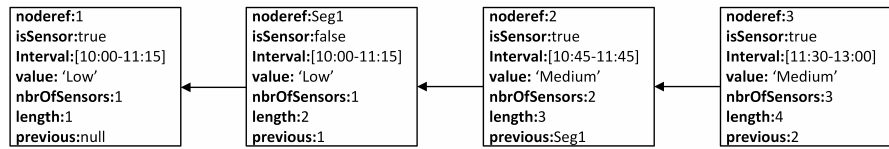
Figure 10. Transformed graph obtained as a result of the example